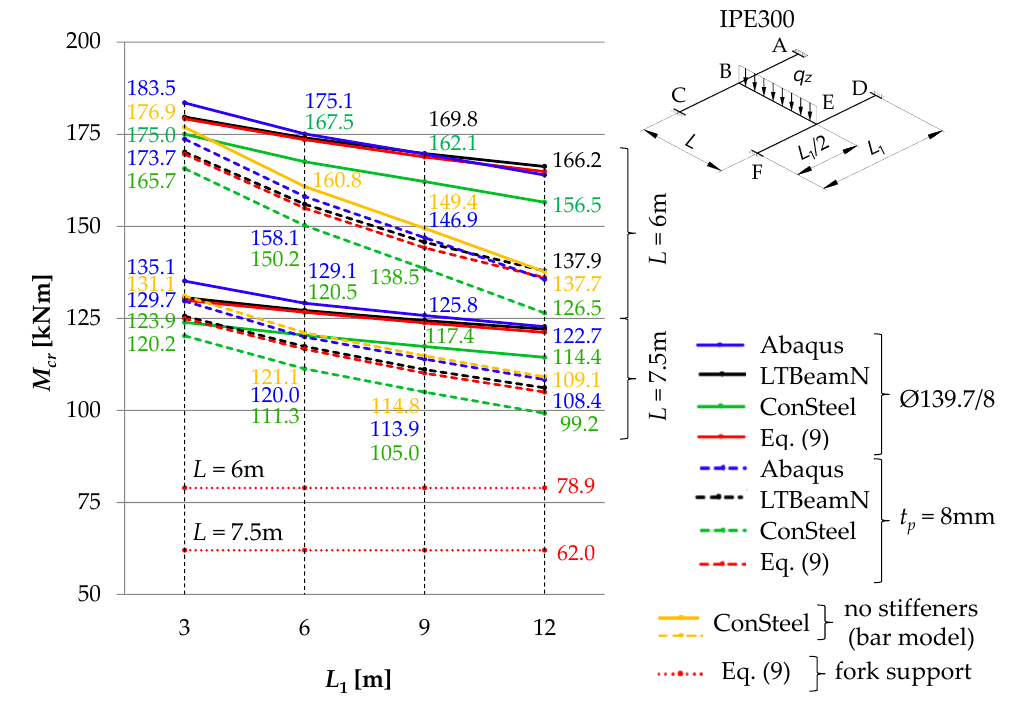
Figure 11. M cr of the critical (main) beam B – E with uniformly distributed load as a function of the span L 1 of the supporting beams A – C and D – F.